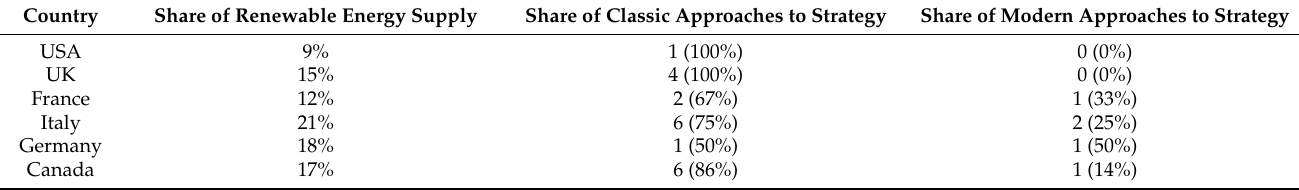
Table 13. Share of approaches to the strategy by country in the studied sample. Country Share of Renewable Energy Supply Share of Classic Approaches to Strategy Share of Modern Approaches to